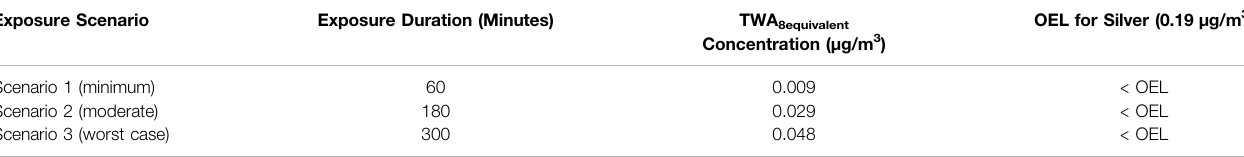
TABLE 7 | An 8-h equivalent exposure concentration compared to the OEL for silver nanoparticles. Exposure